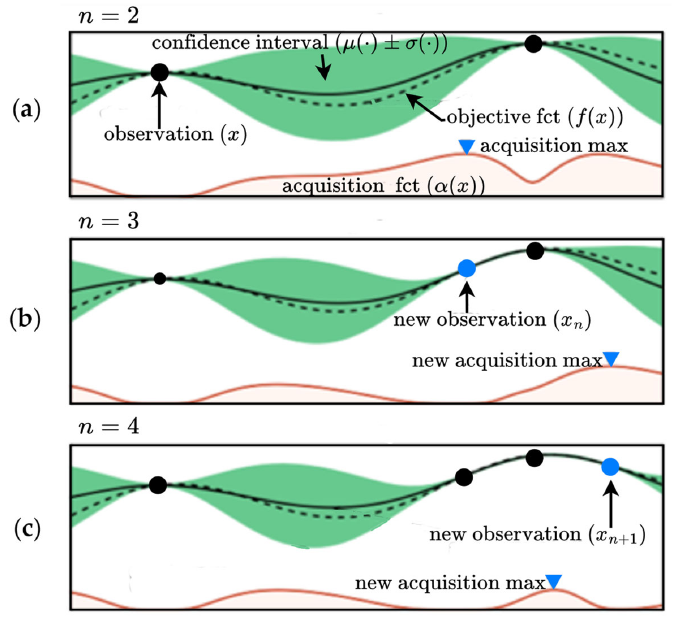
Figure 3. Bayesian optimization methodology: ( a ) Initialization of Gaussian Process model; ( b ) Update of Gaussian Process model; ( c ) Improve Gaussian Process model iteratively. Figure adapted from [36].